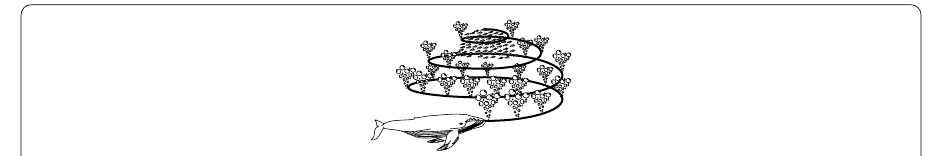
Fig. 1 Bubble-net feeding behavior of humpback